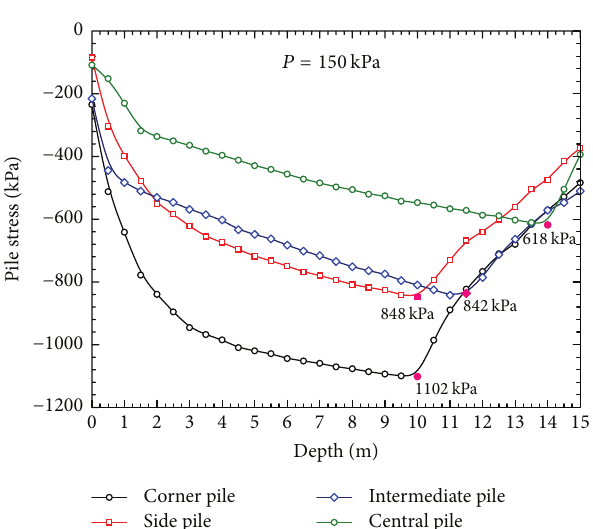
Figure 11: Distribution of the CFG piles stress with depth.